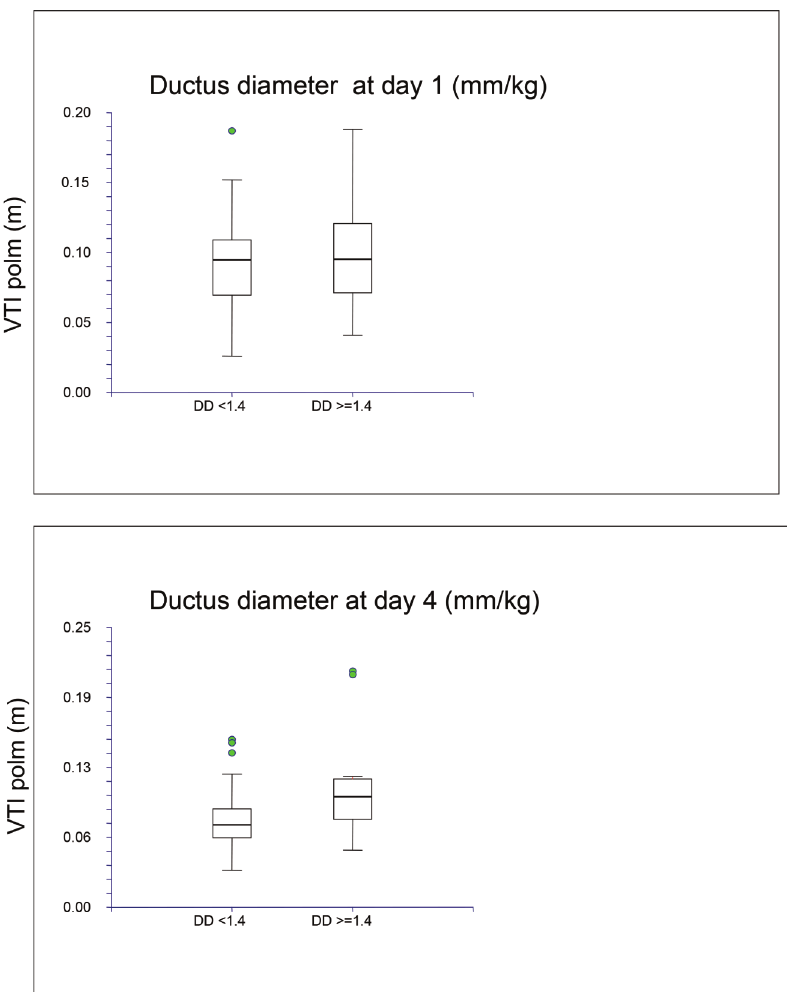
Figure 2 - Relationship between pvVTI and ductus diameter on days 1 and 4 of life.